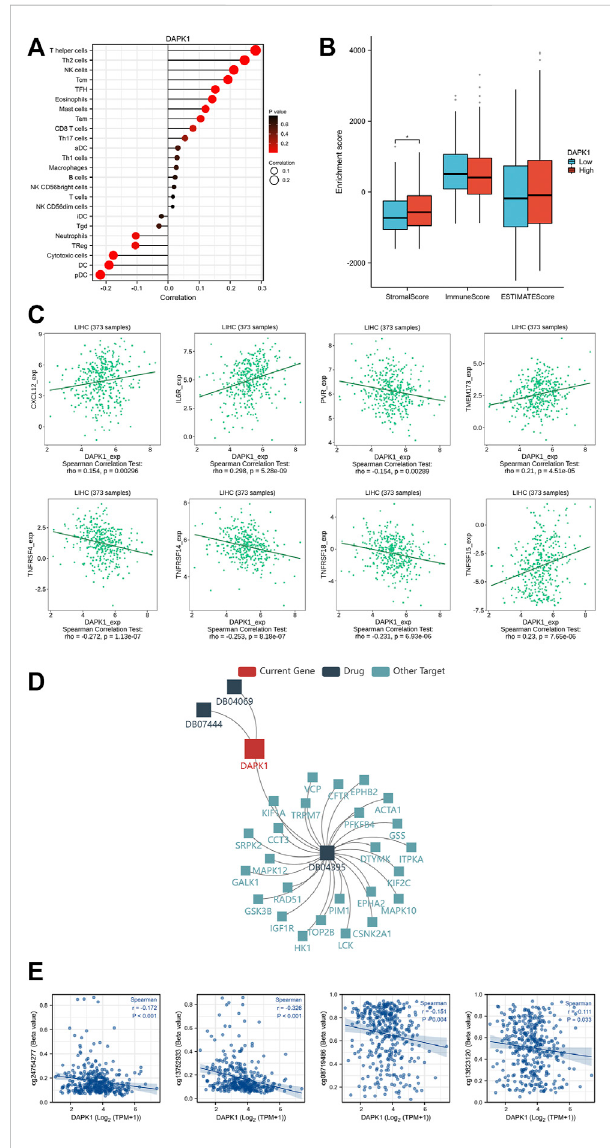
FIGURE 4 Immunecellin fi ltrationlevelsandDNAmethylationofDAPK1. (A) The lollipop diagram of the relationship between the expression of DAPK1 and immune cell in fi ltration levels. (B) The stromal score, immune score, estimate score of different expression level of DAPK1 in HCC. (C) The association between the expression of DAPK1 and immunostimulators. (D) The association between the expression of DAPK1 and target drugs. (E) The DNA methylation level of